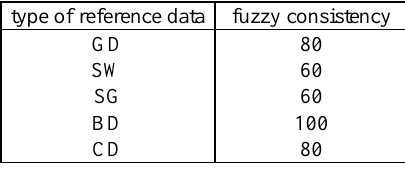
Table 2 . Example of fuzzy consistence